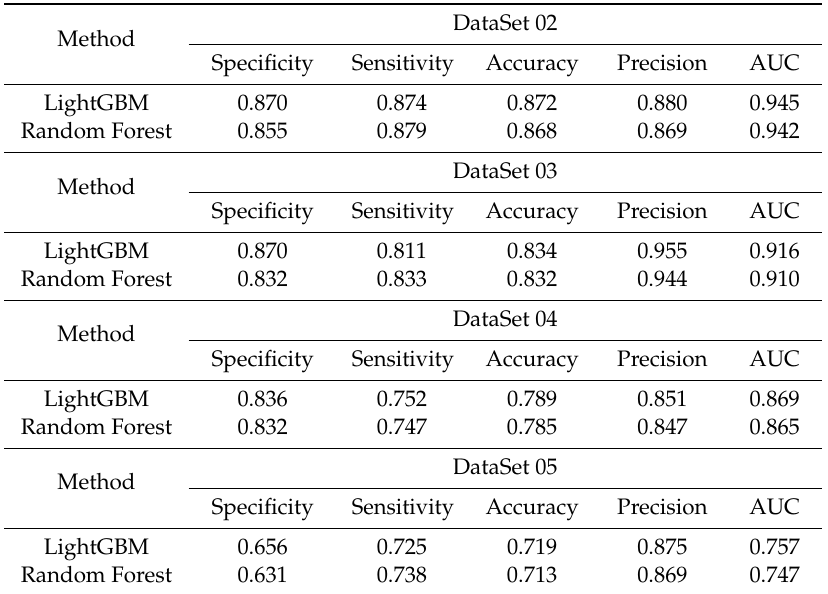
Table 3. Performance comparison between LightGBM and random forest on a training dataset of DataSet 02, DataSet 03, DataSet 04 and DataSet